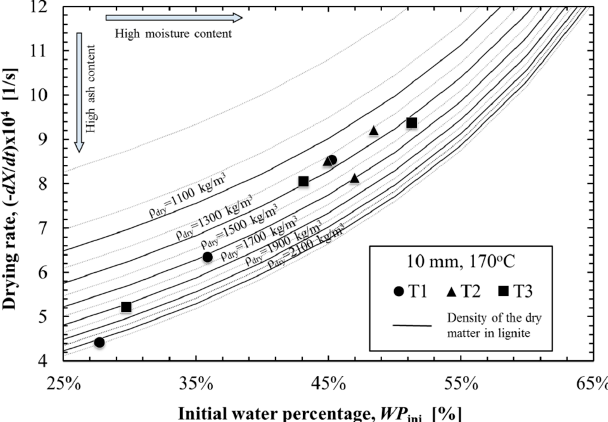
Figure 13. The influence of the WP ini and lignite density (of dry matter) for the initial drying rate at the CDRP.